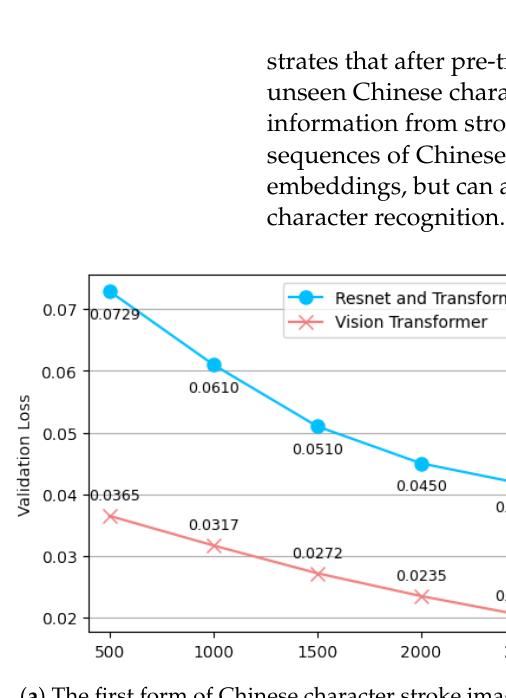
Figure 10. Validation loss on different forms of image sequence label and different architecture. ( a ) is the validation loss on the first form, ( b ) is the validation loss on the second form.